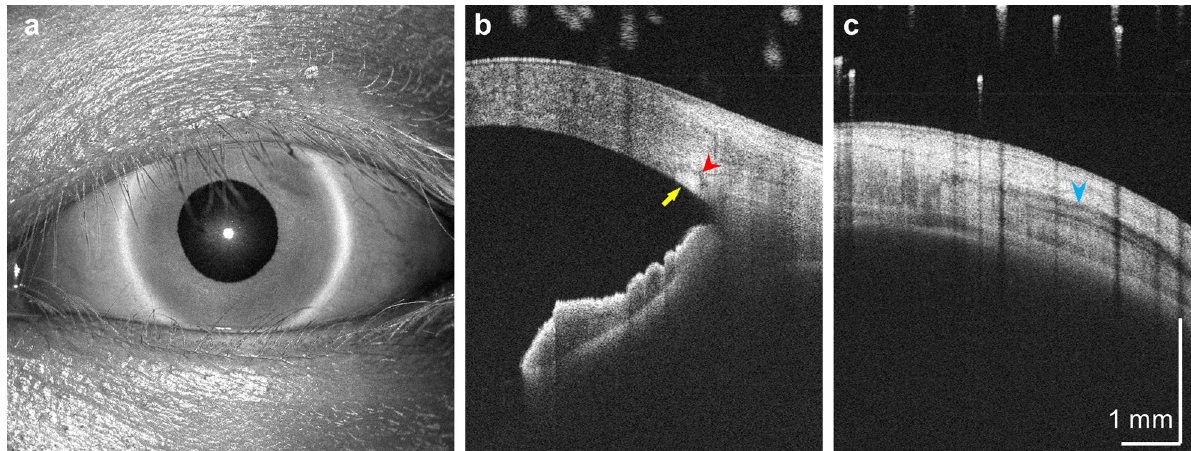
Figure 4. Wide field, long range, deep penetration structural imaging using the SS-OCT prototype instrument. ( a ) En face amplitude projection of a 25-mm OCT volume. ( b ) 6-mm horizontal B-scan centered at the limbus. Yellow arrow: trabecular meshwork. Red arrowhead: Schlemm’s canal. The connected hypo-reflective curvilinear feature may correspond to a collector vessel segment. ( c ) 6-mm horizontal B-scan 6 mm temporal to the corneoscleral junction. Blue arrowhead: insertion tendon of the lateral rectus